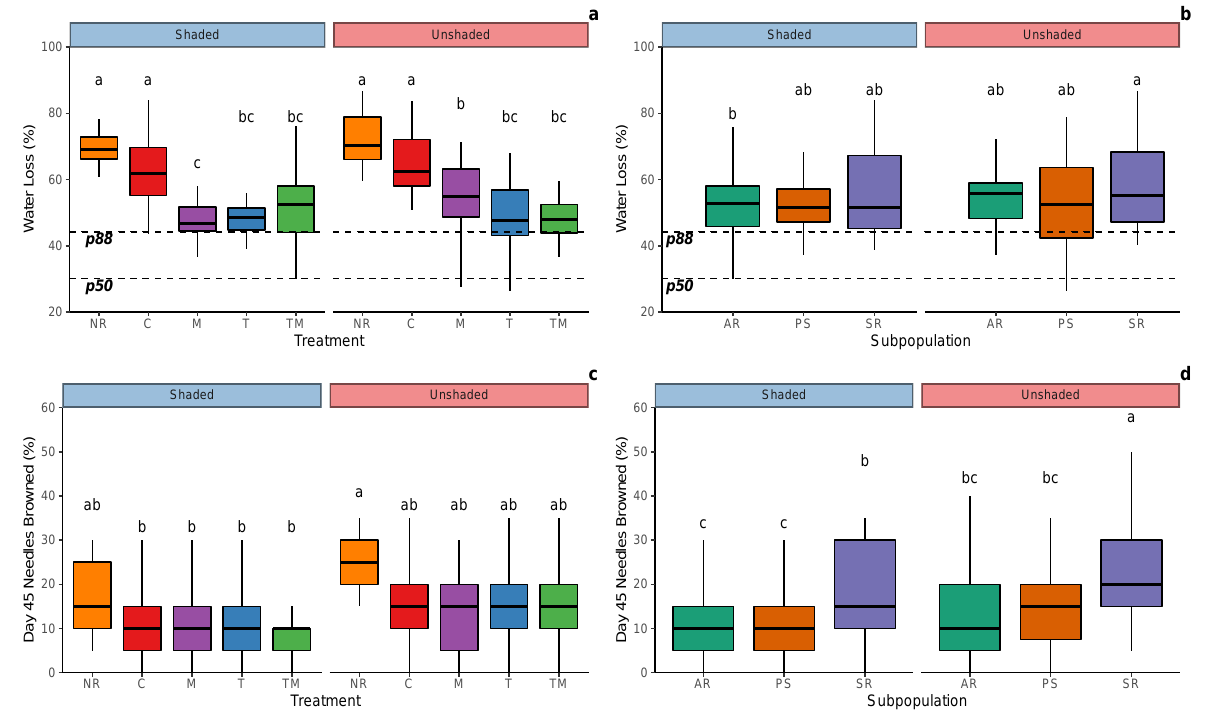
Figure 5. Relative water loss [RWL: % xylem conduits cavitated] among treatment groups in shaded and unshaded microsites (Panel ( a )), relative water loss among subpopulations in shaded and unshaded microsites (Panel ( b )), needles browned on the last experiment day among treatment- microsite groups (Panel ( c )), and needles browned among subpopulation-microsite groups (Panel ( d )). In Panels a and b, p50 and p88 refer to 50% and 88% loss of conductivity, respectively, inferred through relative water loss [41]. Letters indicate statistically significant groupings in each panel, determined by ANOVA and Tukey’s honest significant differences ( p < 0.05).